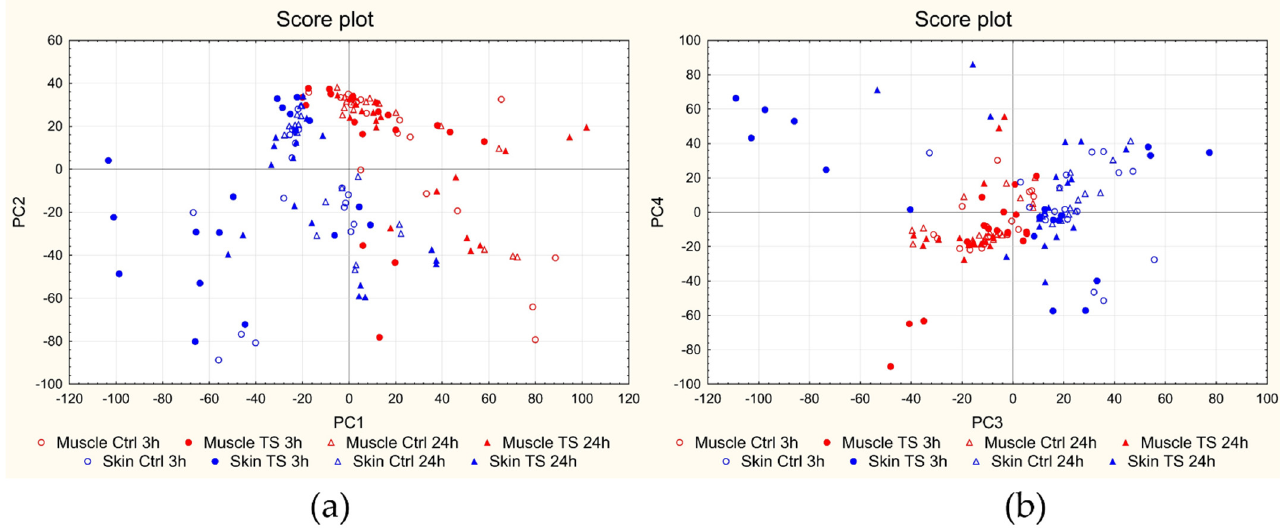
Figure 4. Results of PCA on the overall dataset in first derivative: score plots of PC 2 vs PC 1 ( a ) and of PC 4 vs PC 3 ( b ). Muscle measurements are indicated in red and skin measurements in blue; empty circles = controls at 3 h (18 muscle and 18 skin samples); full circles = 3 h treated (18 muscle and 18 skin samples); empty triangles = controls at 24 h (18 muscle and 18 skin samples); full triangles = 24 h treated (18 muscle and 18 skin samples).